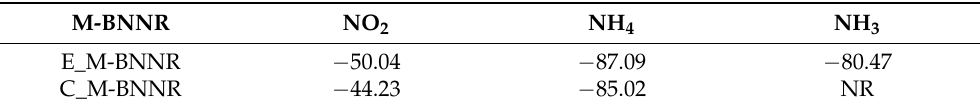
Table 2. Interaction energy of the most stable complex between the analyzed toxic molecules on the M-BNNR, measured in